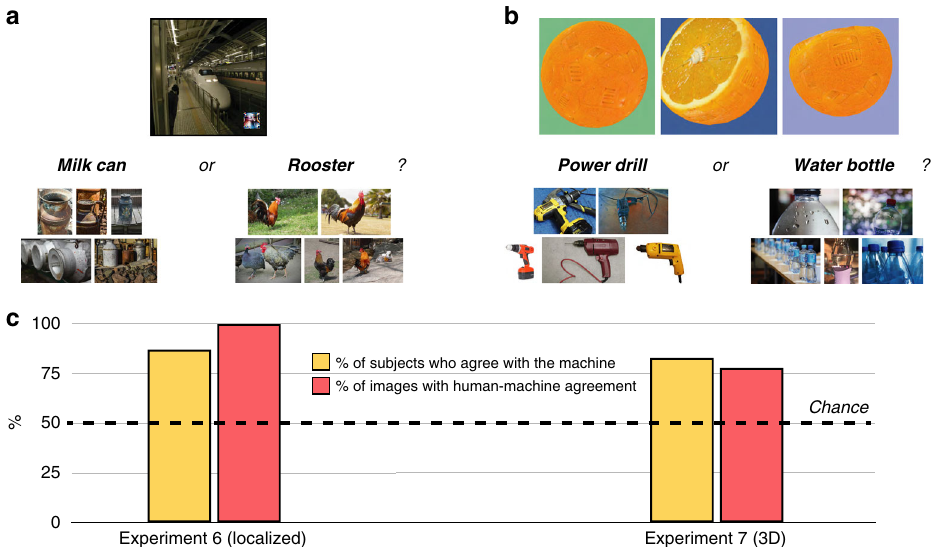
Fig. 4 Classi fi cation with perturbed natural images and 3D objects. a In Experiment 6, 200 subjects saw natural photographs that had a small adversarial perturbation in the bottom right corner of the image (22 images total); the subjects ’ task was to choose between the machine ’ s choice for that image and a random label drawn from the other images in the imageset (which were accompanied by images of each target class for reference). b In Experiment 7, 400 subjects saw three viewpoints of a rendered 3D object whose adversarial perturbation caused a machine to misclassify (106 images total, of which each subject saw 53); the subjects ’ task was to choose between the machine ’ s choice for that object and a random label drawn from the other objects in the imageset (with images of each target class for reference). c Most subjects agreed with the machine more often than would be predicted by chance responding, and most images showed human-machine agreement more often than would be predicted by chance responding (including every one of the LaVAN images). For Experiment 6, the 95% con fi dence interval for the % of subjects with above-chance classi fi cation was [82.5% 91.9%], and [84.6% 100%] (one-sided 97.5% con fi dence interval) for the % of images with above-chance classi fi cation. For Experiment 7, these intervals were [78.7% 86.5%] and [70.5% 86.1%], respectively. Across both experiments, these outcomes were reliably different from chance at p < 0.001 (two-sided